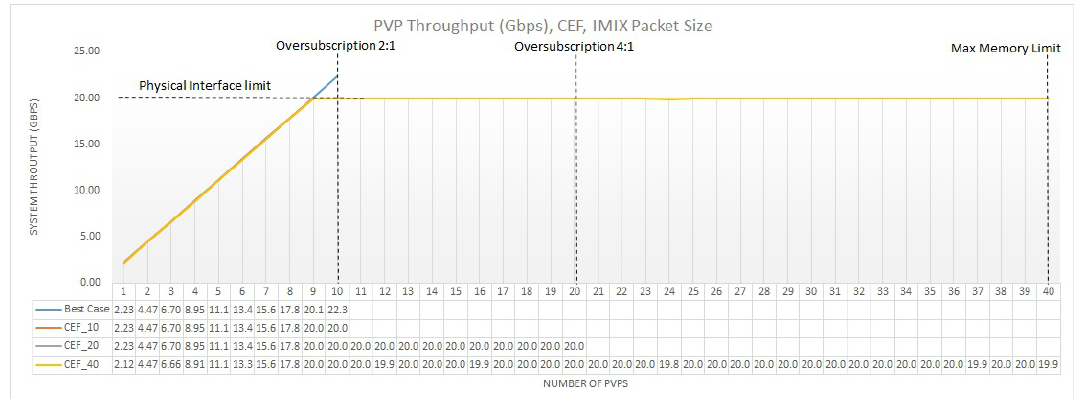
Figure 10. Single-Feature multi-PVP system throughput with